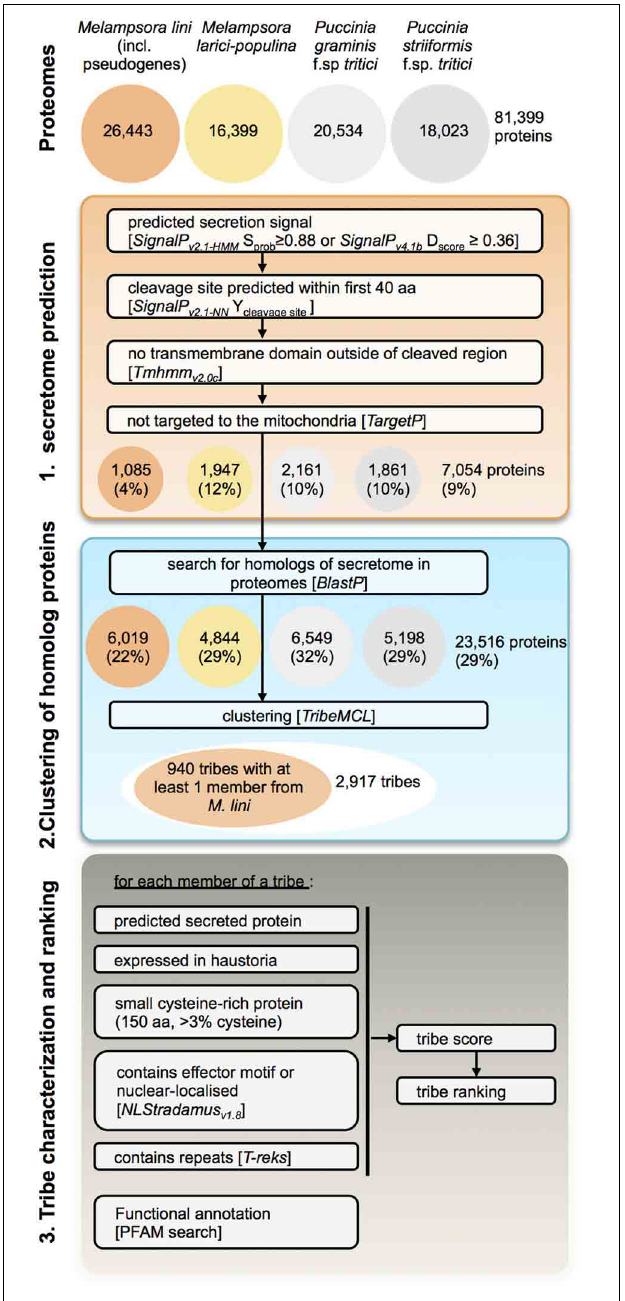
FIGURE 3 | Pipeline for prediction of candidate rust fungal effectors. Tribes of predicted secreted proteins were gathered from the proteomes of M. lini isolate CH5, M. larici-populina isolate 98AG31, P. graminis f.sp tritici isolateCDL75–36-700–3 (race SCCL)and P.striiformis f.sp. tritici isolate130. Tribes containing at least one member from M. lini were selected for characterization and ranking.